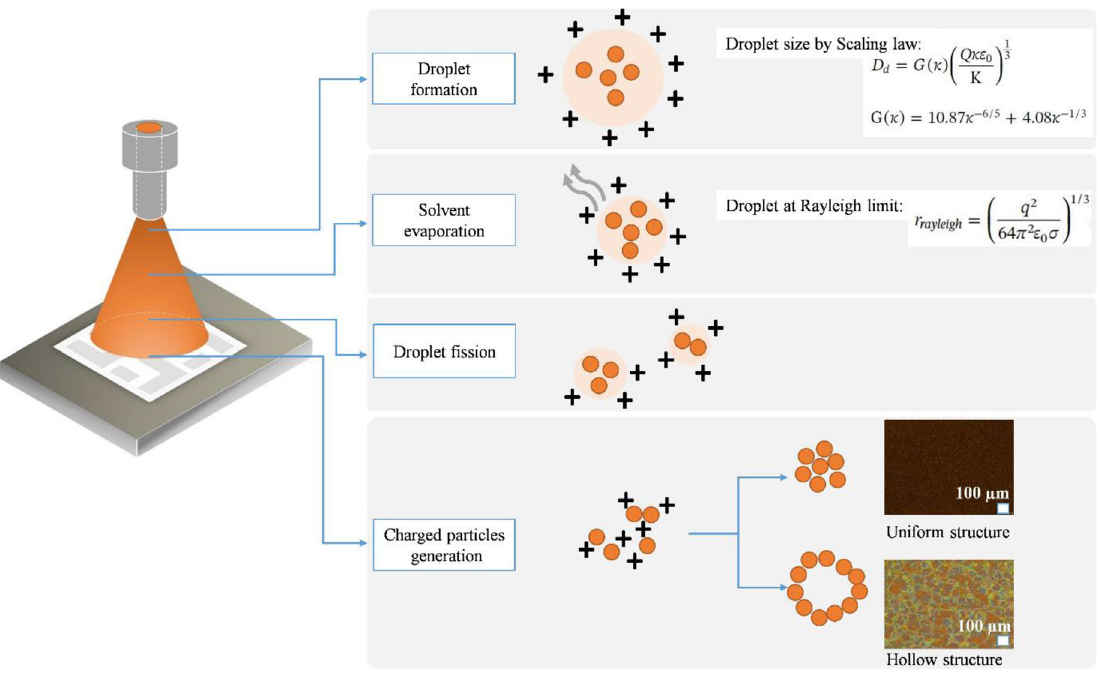
Figure 2. Mechanism of QD thin film formation by EHD